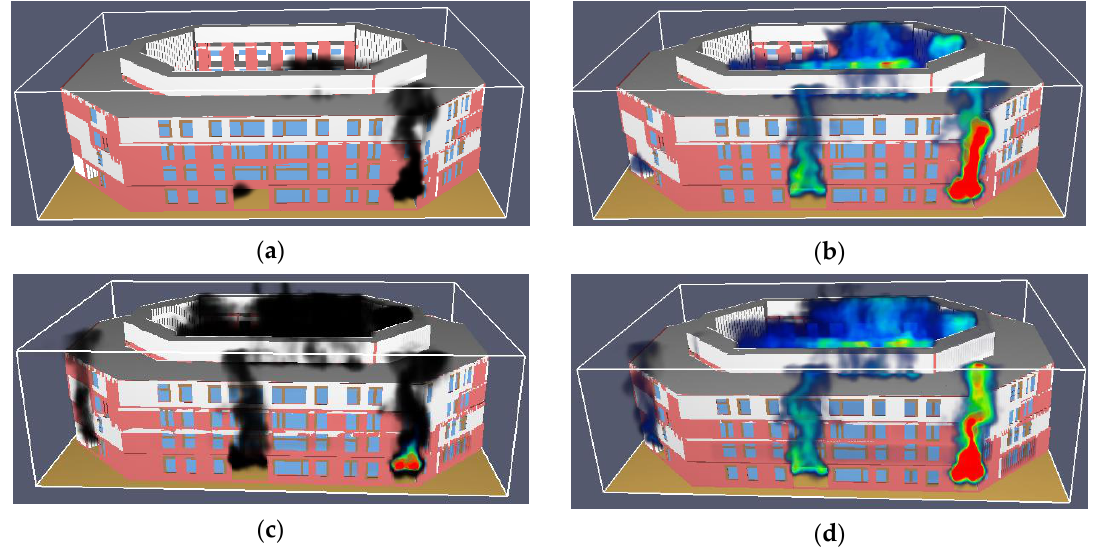
Figure 8. SmokeView simulation results for different combustion times: ( a ) 60 s; ( b ) 120 s; ( c ) 240 s; ( d ) 600